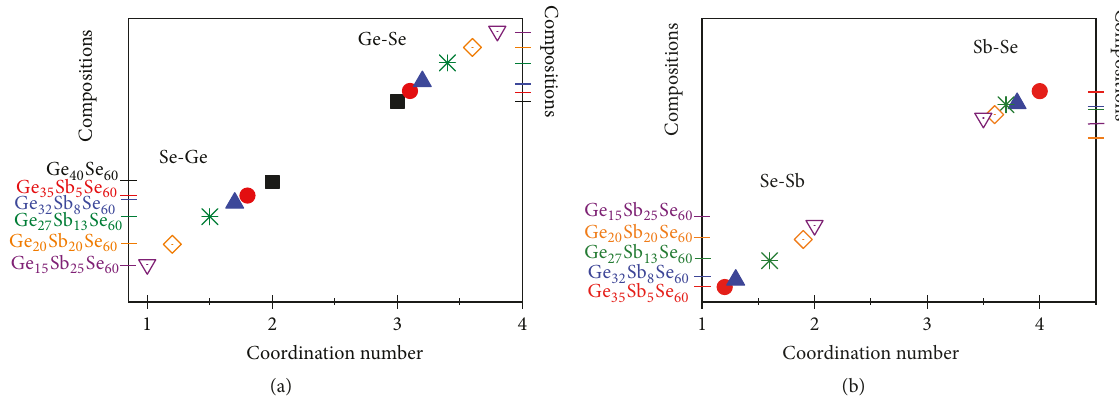
Figure 4: Coordination number distributions, 𝐶𝑁 ij , for the Ge-Se and Se-Ge bonds (a) and Sb-Se and Se-Sb bonds (b) in the corresponding compositions of Ge 40 Se 60 (black square), Ge 35 Sb 5 Se 60 (red circle), Ge 32 Sb 8 Se 60 (blue triangle), Ge 27 Sb 13 Se 60 (green crosses), Ge 20 Sb 20 Se 60 (orange square), and Ge 15 Sb 25 Se 60 (purple reverse triangle).